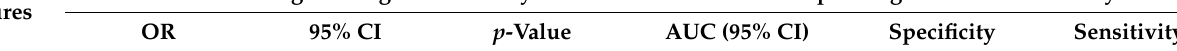
Table 2. Multivariate logistic regression analysis evaluating the associations between serum hormone levels and granulosa cell tumors with receiver operating characteristic curve analysis for granulosa cell